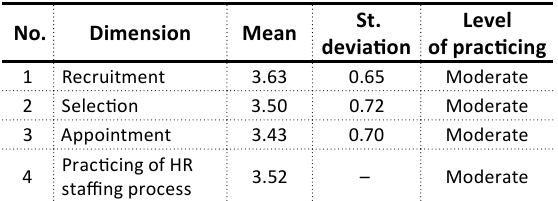
Table 1. Human resources staffing